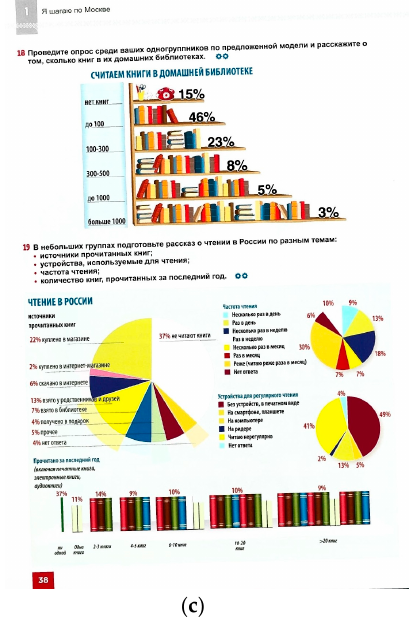
Figure 7. ( a – c ) Example 1 of a task in Davayte .